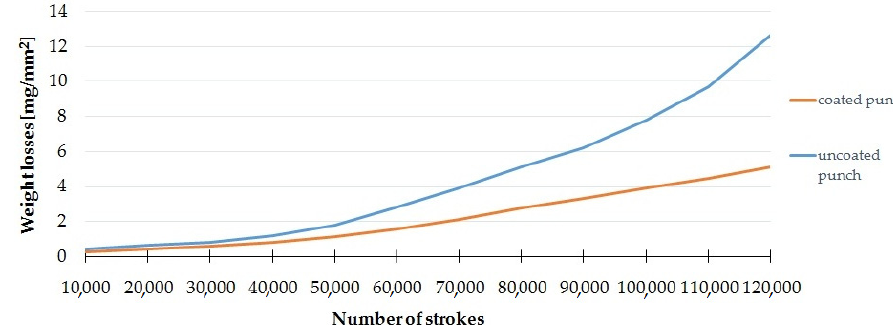
Figure 7. Weight loss and number of strokes.